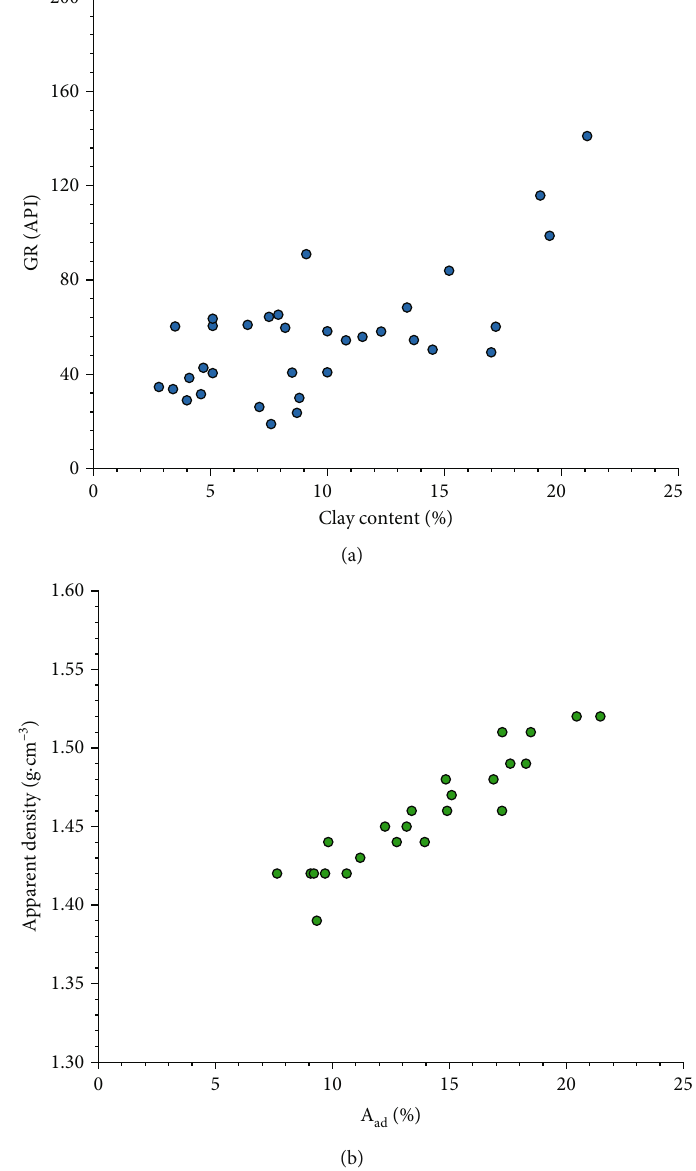
Figure 11: Cross plot experimental data: (a) relationship between clay mineral content and GR; (b) relationship between ash content and laboratory apparent density of samples under air drying